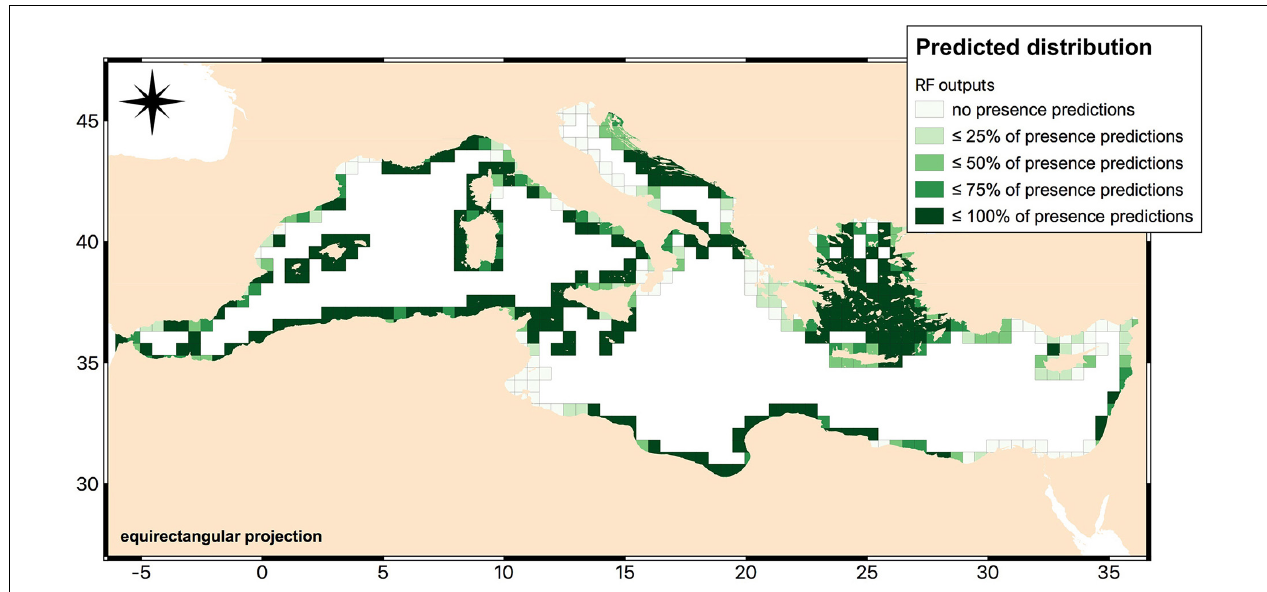
FIGURE 8 | Map of the predicted distribution of Cystoseira infralittoral species according to RF outputs. The map is based on a combined dataset of canopy-forming species and records of species which may not be “forest”-forming (e.g., C. compressa ). It has been created with QGIS software (QGIS Development Team, 2018. QGIS Geographic Information System. O3.Open Source Geospatial Foundation: